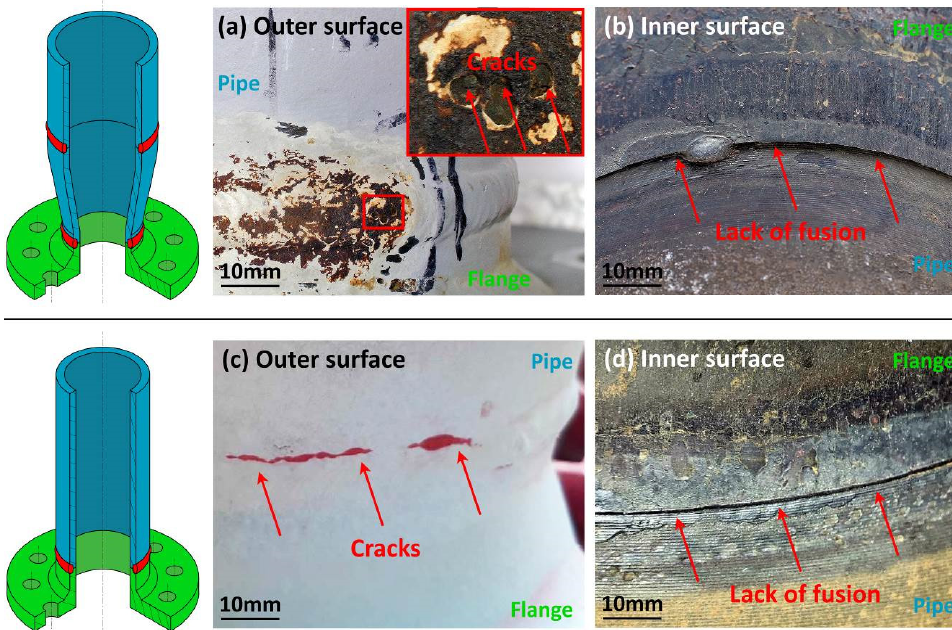
Figure 2. Outer and inner surfaces of the two types of welded joints under investigation. Cracks next to the welding bead are clearly visible in pictures ( a , c ). Pictures ( b , d ) show the lack of fusion and the step in the contact region between the welded parts.